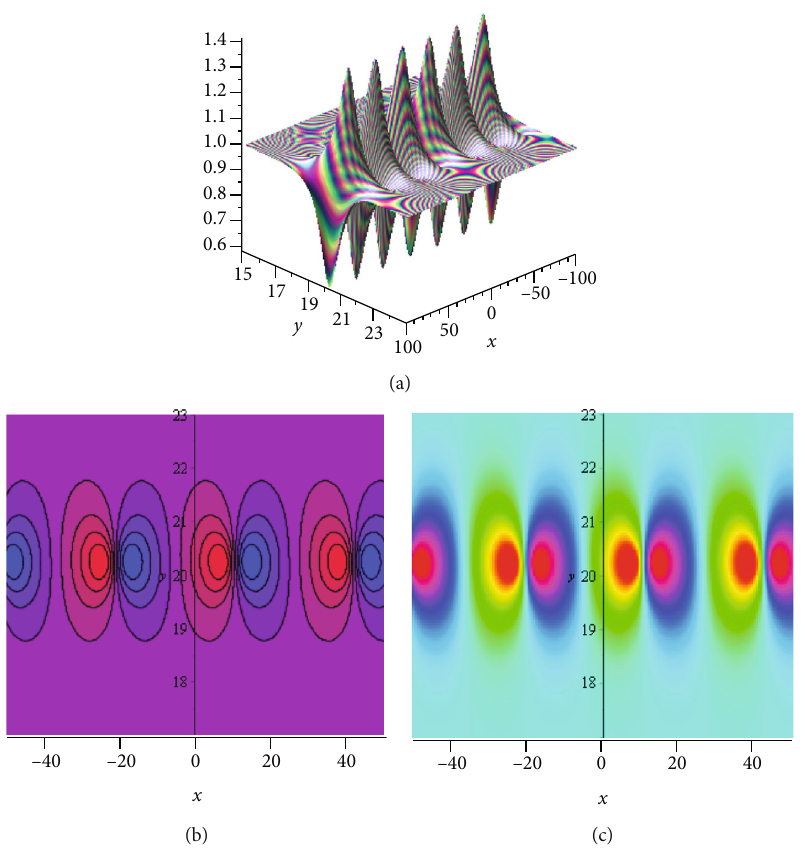
= : 5, a = 1 : 5, a = 2, a = 1, Ω = 1 : 9, Ω = : 2, Ω = 2, δ = 1, δ = 1 : 3, δ 1 2 3 4 2 4 9 1 2 3